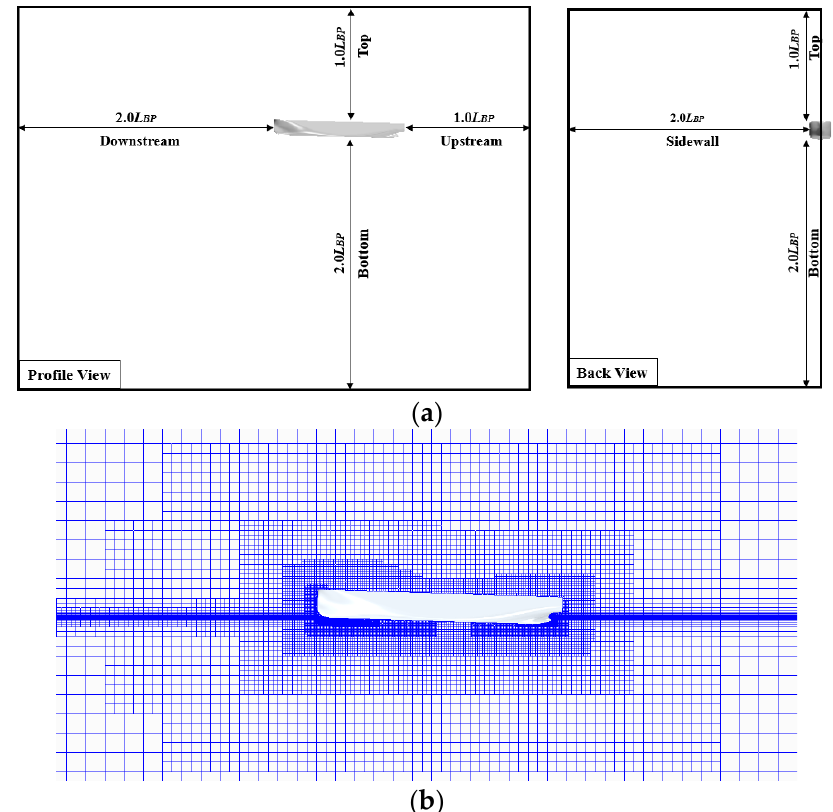
Figure 4. Overview of computational domain and mesh: ( a ) position arrangement of computational domain and ( b ) longitudinal section of mesh.